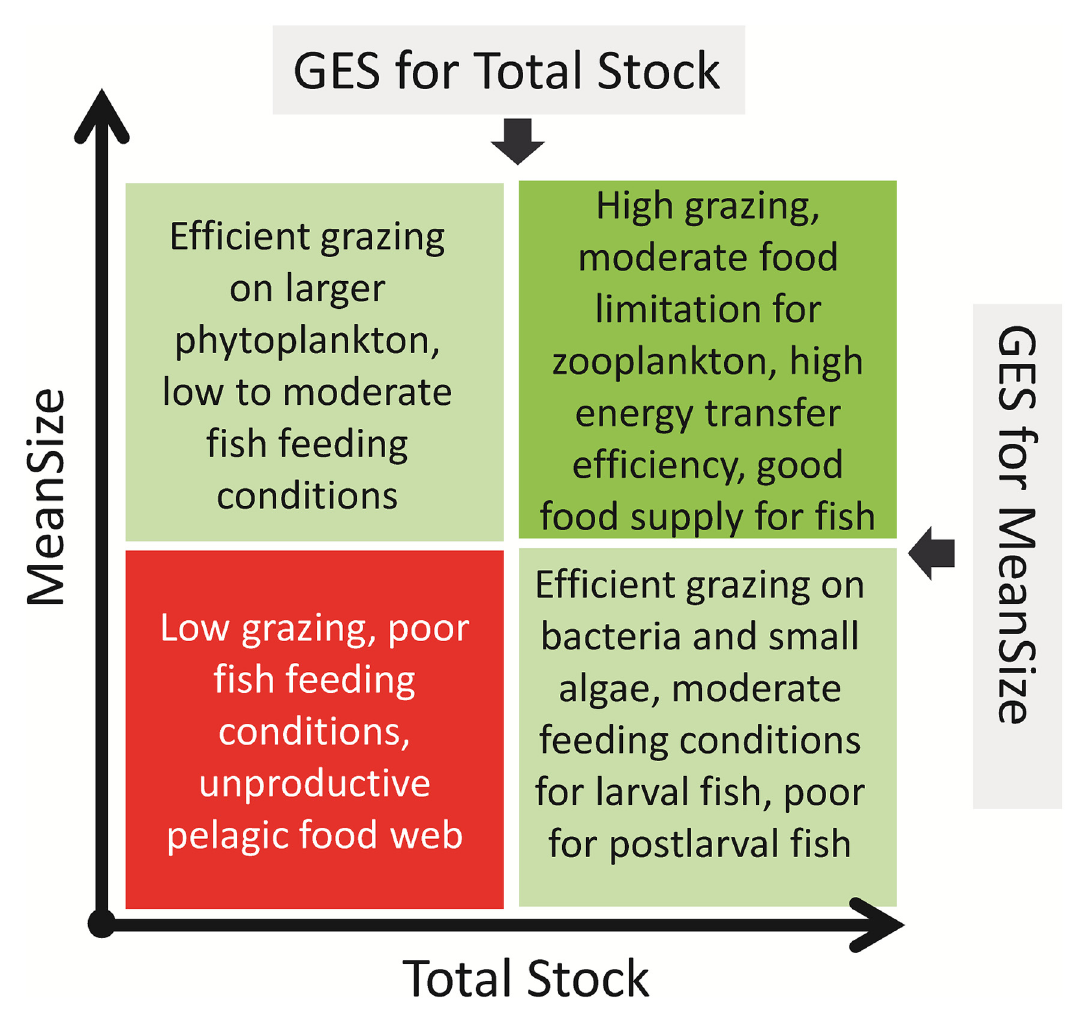
Fig 4. Conceptual diagram for MSTS, a two-dimensional indicator comprised by total stock (TZA or TZB) and MeanSize. The green area represents in-GES condition, orange areas represent sub-GES conditions where only one of the two parameters is adequate, and the red area represents sub-GES conditions where both parameters